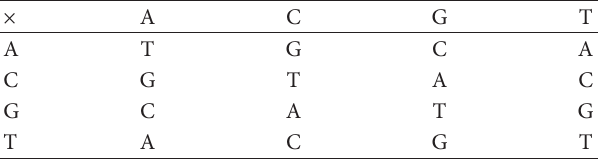
} and used. Two DNA sequences 𝐼 1 = {𝑑 11 , 𝑑 12 , . . . , 𝑑 1𝑙 𝐼1 𝐼 = {𝑑 , 𝑑 , . . . , 𝑑 } are given. Their lengths are 𝑙 2 21 22 2𝑙 𝐼2 𝐼 1 and 𝑙 𝐼 . 𝐼 1 and 𝐼 2 are reconstructed as two matrices 𝐷 1 = 2 , 𝑑 , . . . , 𝑑 ] −1 and 𝐷 = [𝑑 , 𝑑 , . . . , 𝑑 ] . Perform- [𝑑 11 12 1𝑙 𝐼1 2 21 22 2𝑙 𝐼2